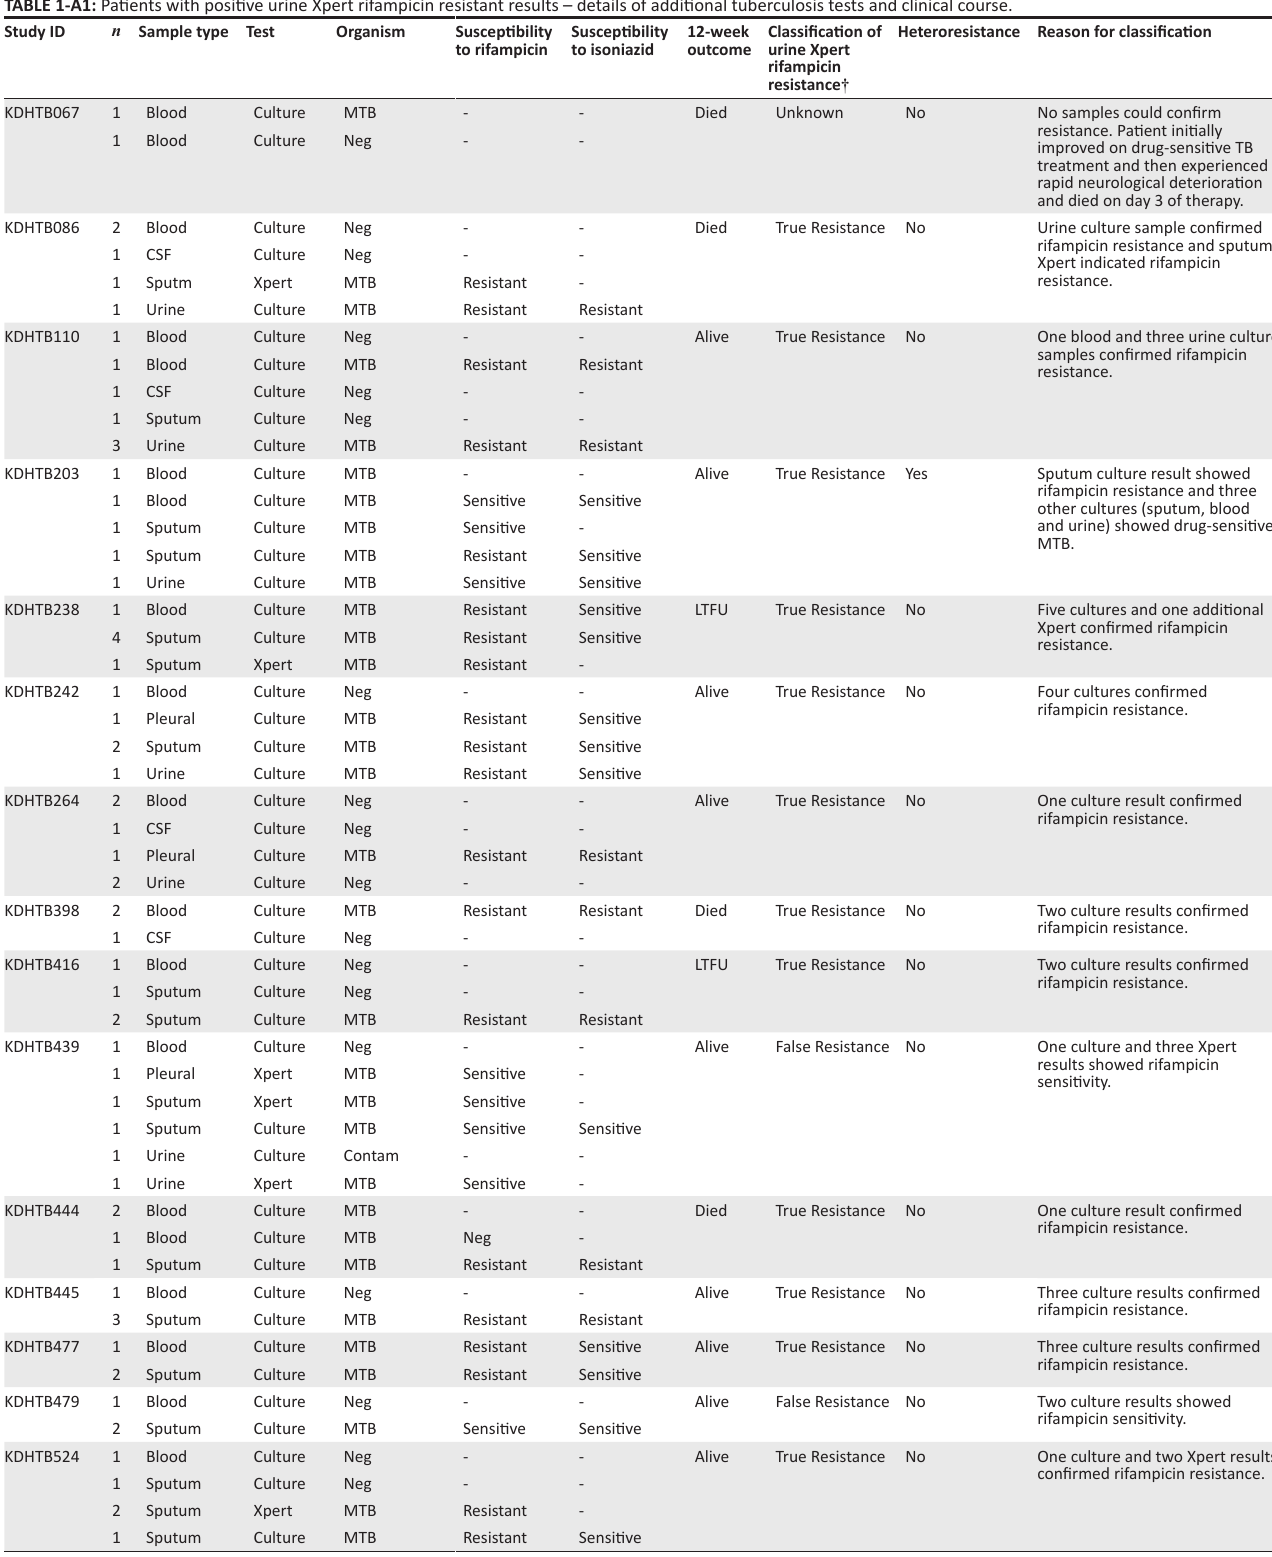
TABLE 1-A1: Patients with positive urine Xpert rifampicin resistant results – details of additional tuberculosis tests and clinical course. Study ID n Sample type